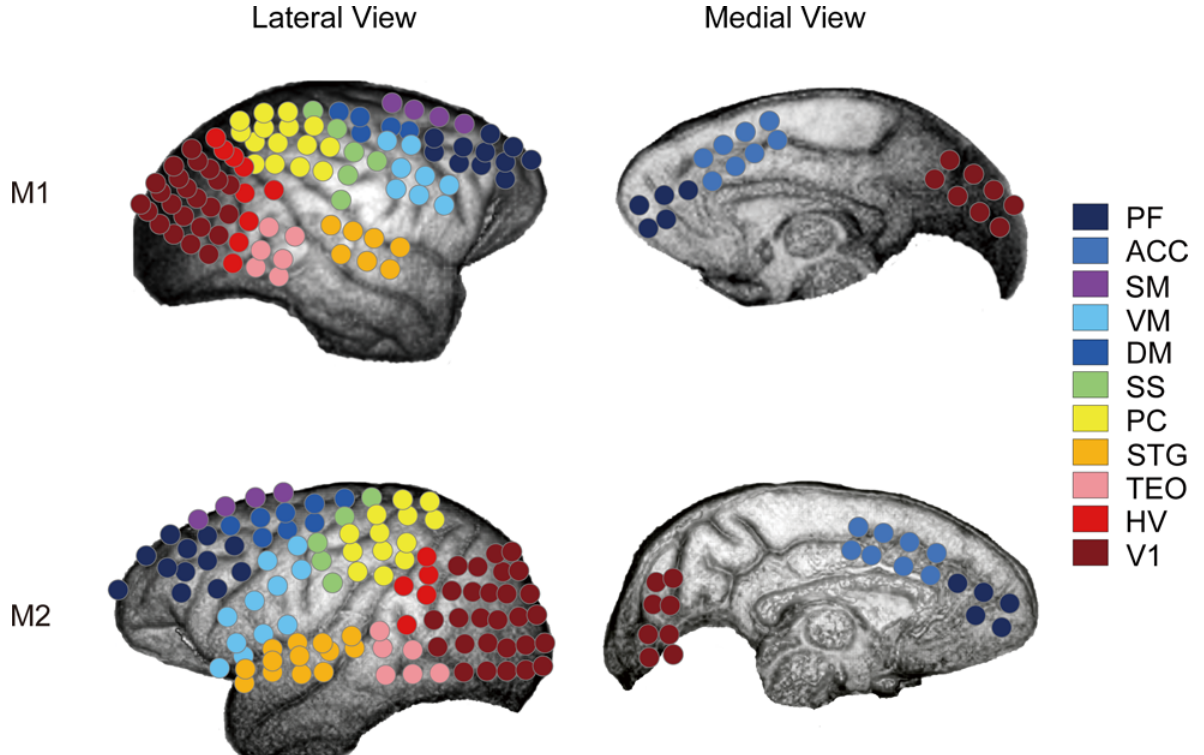
Fig 2. ECoG electrode arrays on the cortical surface of the TM. Electrode locations for M1 and M2 are indicated by circles on the lateral and medial views of a magnetic resonance image. The colors of the circles represent the cortical regions. PF, lateral and medial prefrontal cortices; ACC, anterior cingulate cortex; SM, supplementary motor cortex; VM, ventral primary and premotor cortex; DM, dorsal primary and premotor cortex; SS, somatosensory cortex; PC, parietal cortex; STG, superior temporal gyrus; TEO, posterior inferotemporal cortex; HV, higher visual cortex (V2 and V4); and V1, primary visual